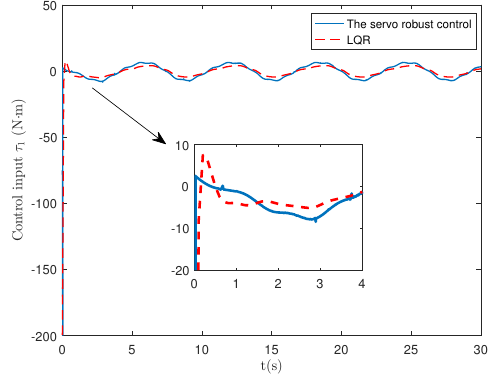
Figure 7. Control force τ 1 .